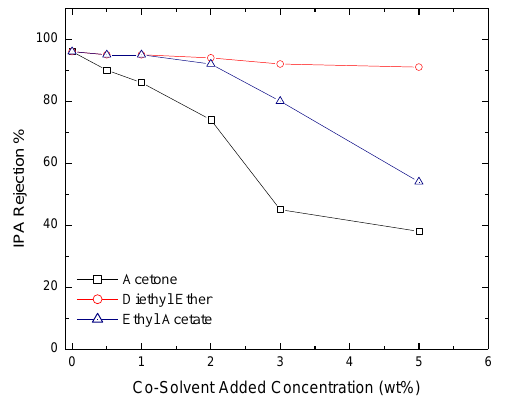
Figure 10. Salt rejection of IPA through membranes formulated with acetone, diethyl ether, and ethyl acetate added as co-solvents.